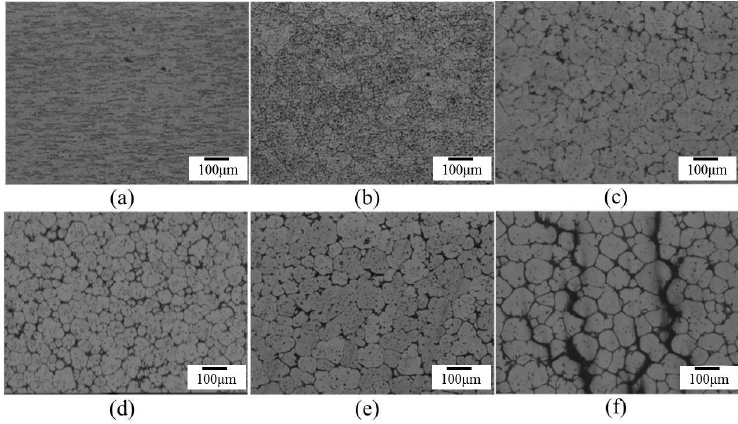
Figure 5. Microstructure of Ex3 after immersion in salt bath at various time periods (represented by signals in Table 2): ( a ) SB3/550 ‐ 30; ( b ) SB3/570 ‐ 30; ( c ) SB3/590 ‐ 30; ( d ) SB3/610 ‐ 30; ( e ) SB3/620 ‐ 30; ( f ) SB3/630 ‐ 7. SB3: salt bath material with 3 mm thickness.